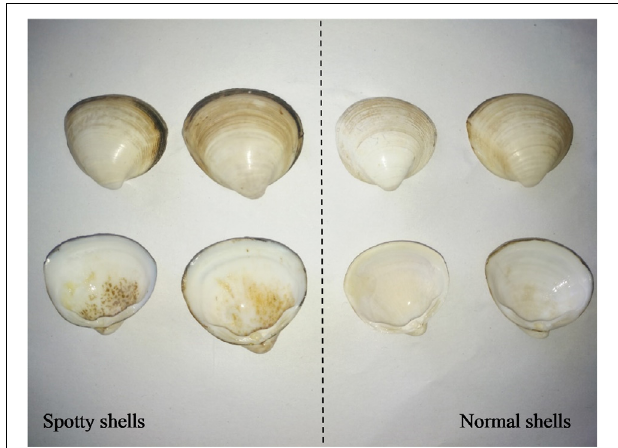
FIGURE 1 | The examples of spotty shells and normal ones of Mactra veneriformis . Left, the clams with the yellow-brown spots on the inner shell surface; right, the normal clams.